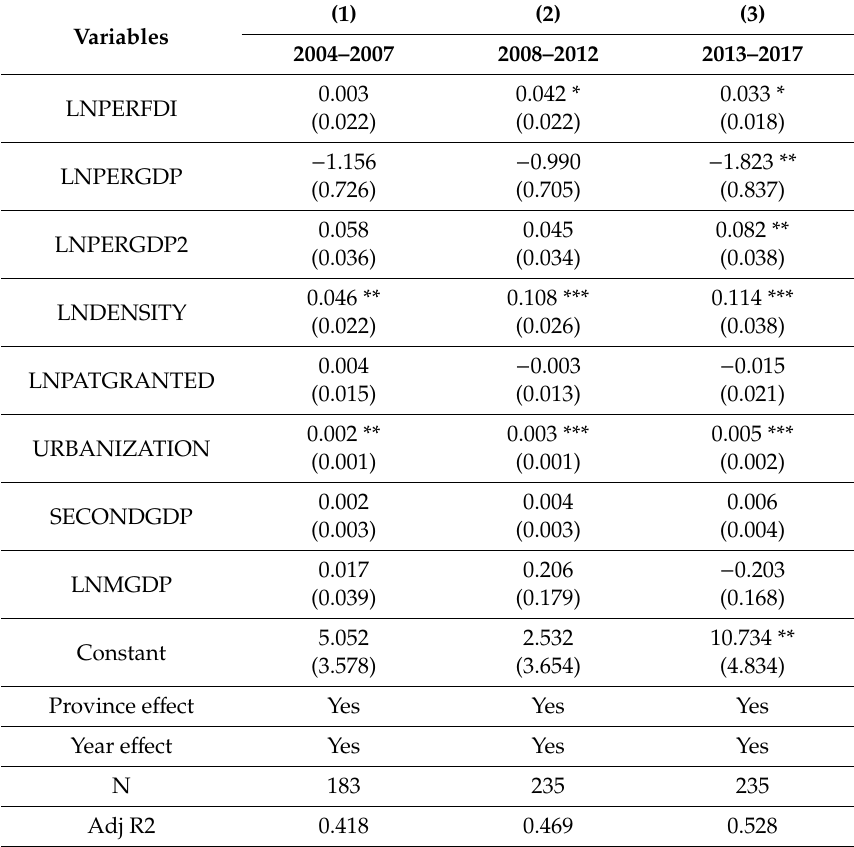
Table 6. Estimated results of the periods before 2007, 2007–2012, and